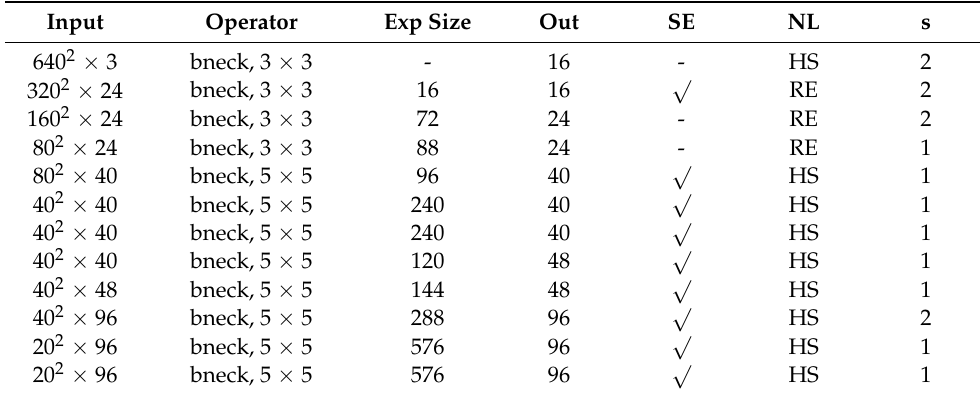
Table 2. MobileNetv3-Small network structure parameters.